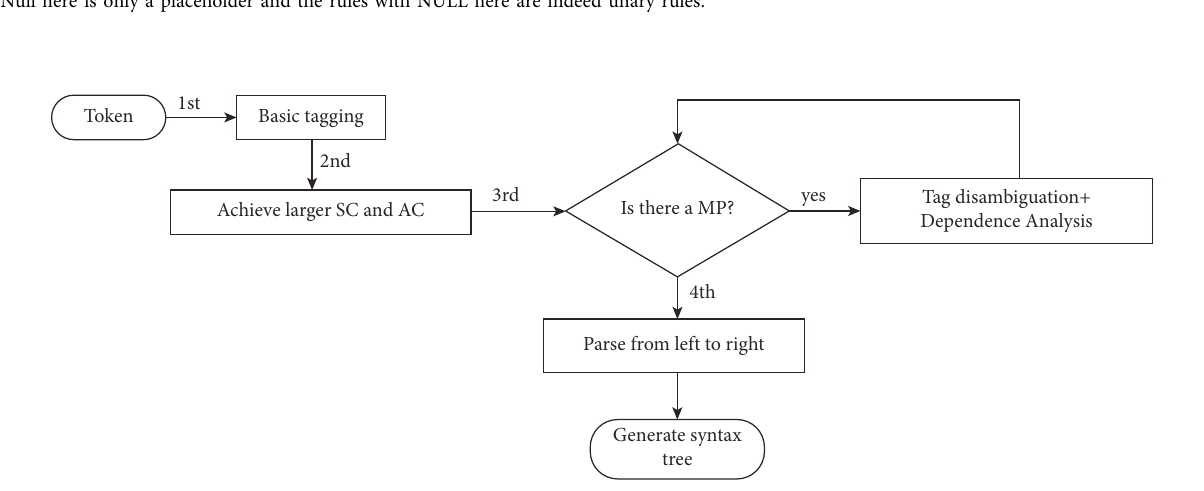
Figure 17: NVN parsing process in